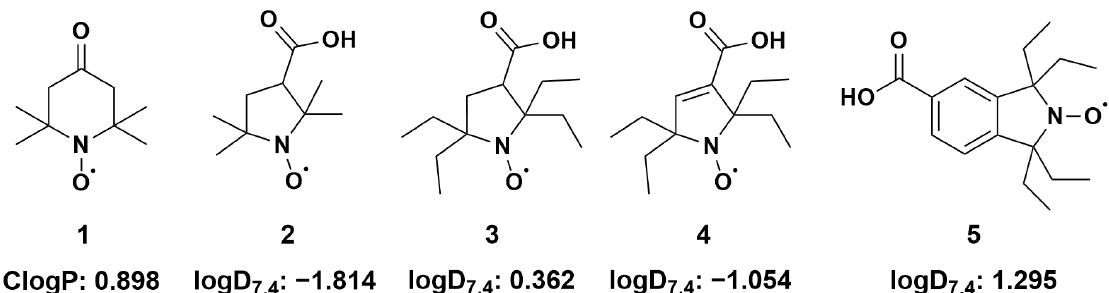
Figure 1. Structural formulas of investigated nitroxides and corresponding ClogP (calcu- lated n-octanol/water partition coefficient) and logD 7.4 (distribution coefficients at pH 7.4). ( 1 ) 2,2,6,6-tetramethyl-4-oxo(piperidine-1-yloxyl) radical (TEMPONE) ( 2 ) 3-carboxy-2,2,5,5- tetramethyl-1-pyrrolidinyloxyl; ( 3 ) 3-carboxy-2,2,5,5-tetraethyl-1-pyrrolidinyloxyl; ( 4 ) 3-carboxy- 2,2,5,5-tetrethyl-pyrrolinyloxyl; ( 5 ) 5-carboxy-1,1,3,3-tetraethyl-2-isoindolinyloxyl; Details of calcula- tions are given in the Material and Methods section and in Supplementary Table